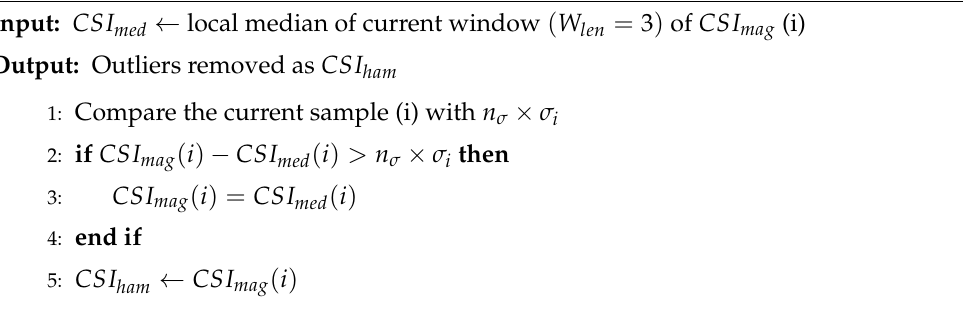
Algorithm 2 O UTLIER R EMOVAL